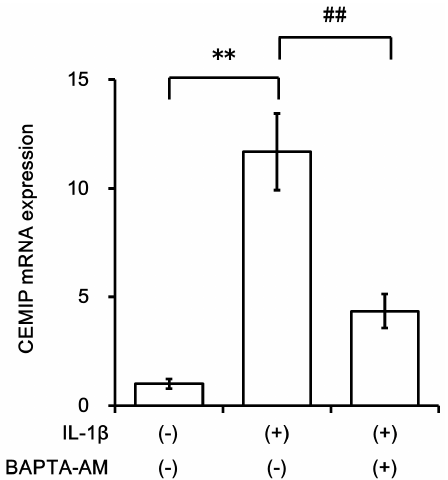
Figure 7. NF- κ B inhibitor (BAPTA-AM) attenuated IL-1 β -induced CEMIP expression. OUMS-27 cells were treated with IL-1 β for 12 h with or without 30 μ M BAPTA-AM. The CEMIP mRNA expression level was measured by qRT-PCR. Values represent mean ± SD ( n = 6 per group). ** p < 0.01 vs. control. ## p < 0.01 vs. IL-1 β with BAPTA-AM-treated group.